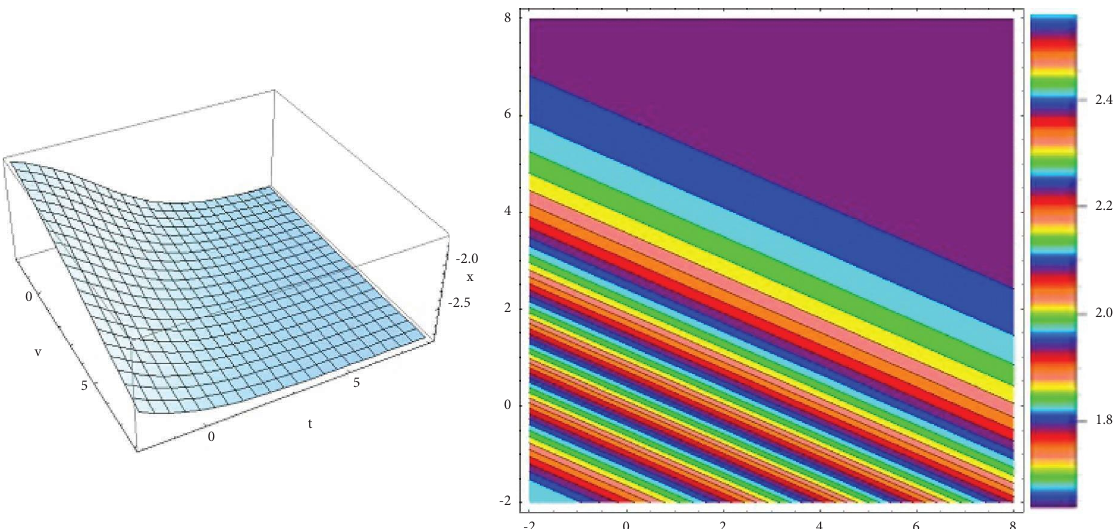
Figure 13: 3D and contour plot soliton drawing from (36) for ω � 0 .